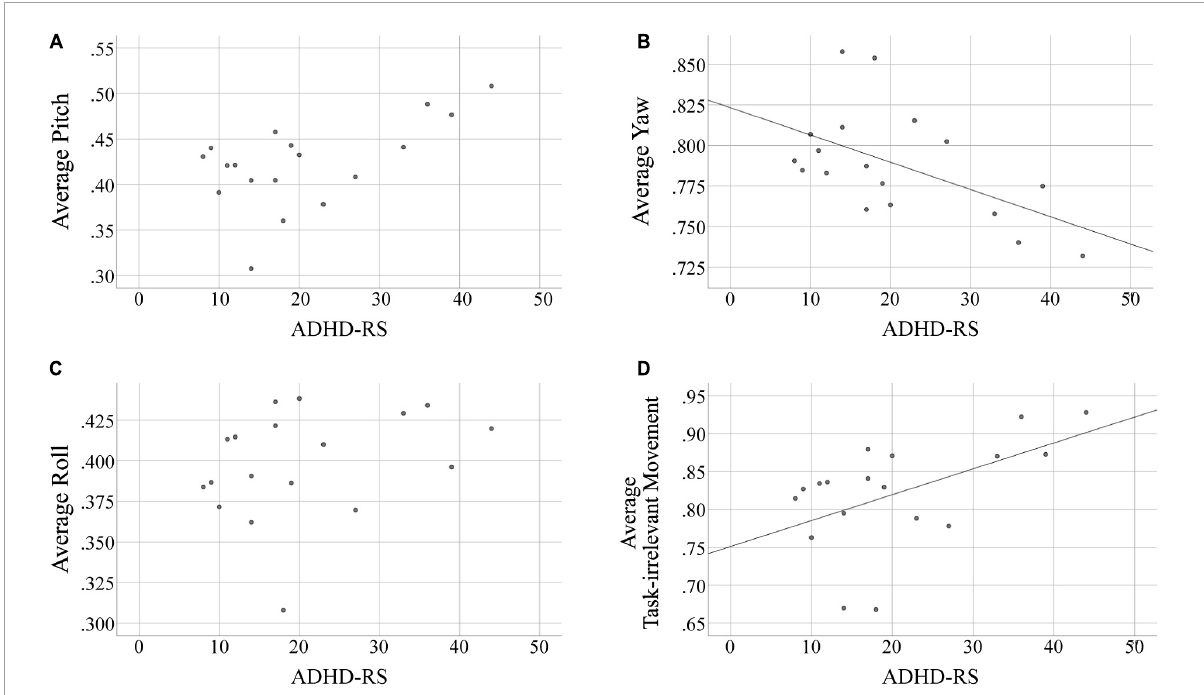
FIGURE2 Correlation analyses in the ADHD group between head movement measurements and the ADHD-RS total score. (A) Correlation with average pitch, (B) correlation with average yaw, (C) correlation with average roll, (D) correlation with average task-irrelevant movement. ADHD-RS total scores of the ADHD group had statistically significant correlations with yaw movement (i.e., task-relevant head movement) and task-irrelevant head movement averaged across all four conditions. Linear fit lines are provided for results with p < 0.05.